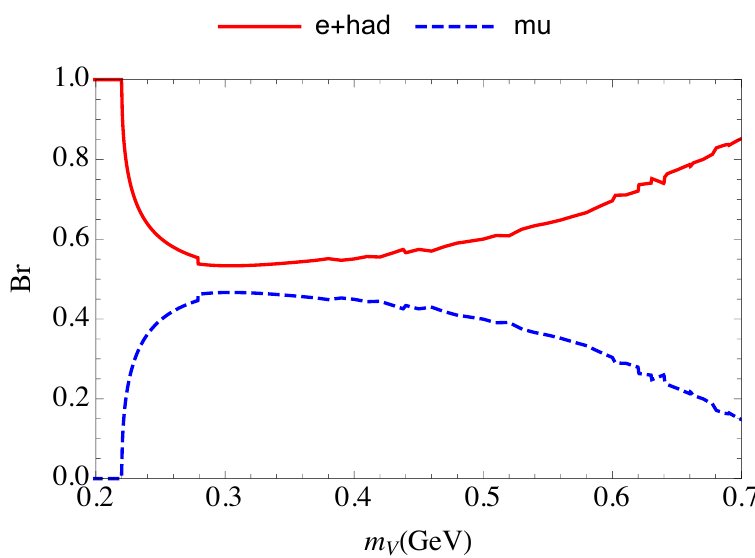
Figure 10 . Branching ratios of the dark photon to electron/hadronic or muon decay channels as a function of the